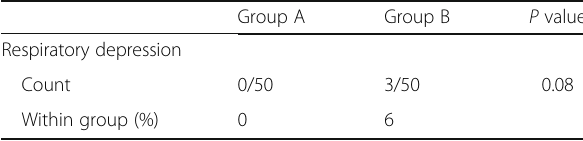
Table 4 Respiratory depression in both groups Group A Group